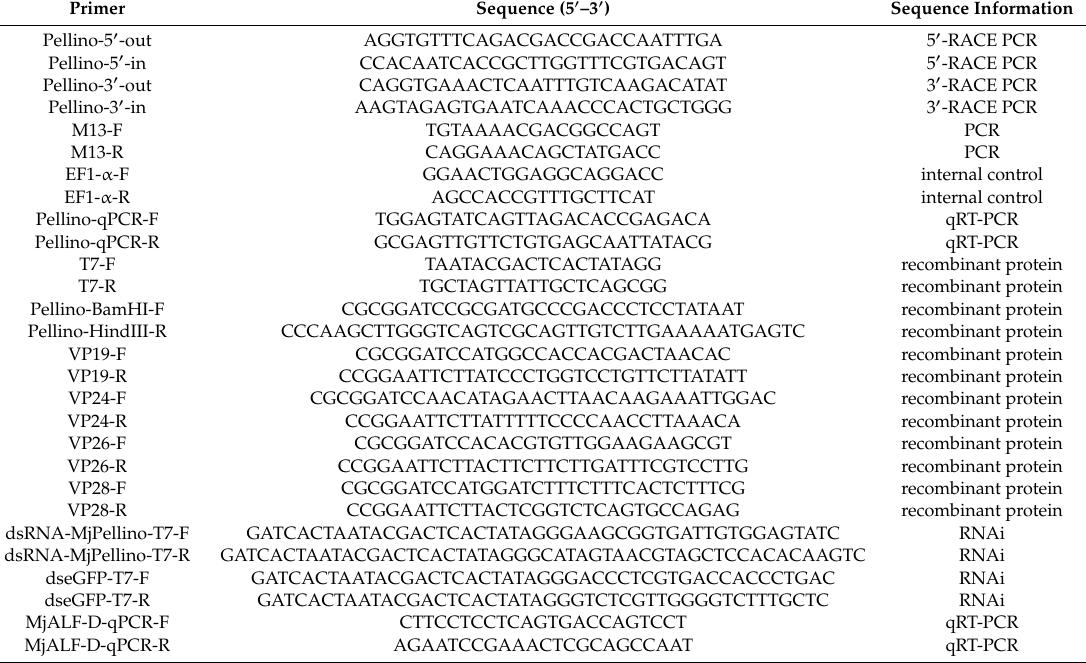
Table 1. Primers used in this